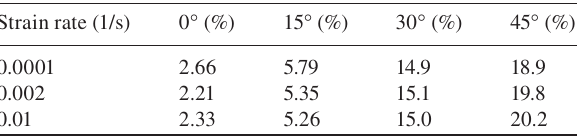
Table 1 Failure strains from clip gauge